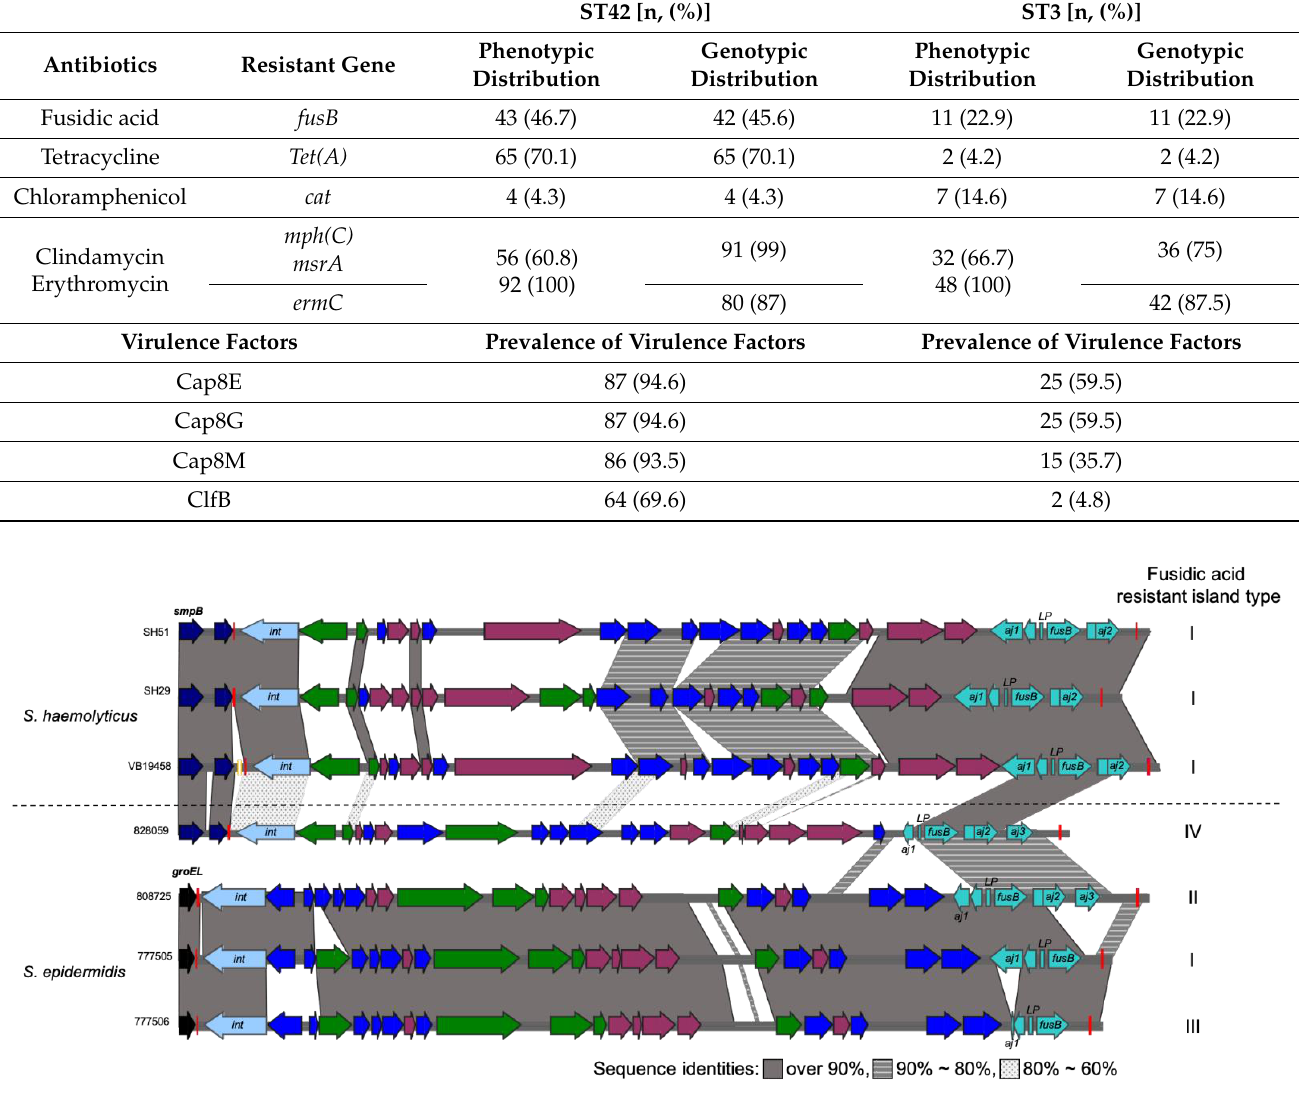
Figure 2. Pairwise comparison of the RI fusB structure.